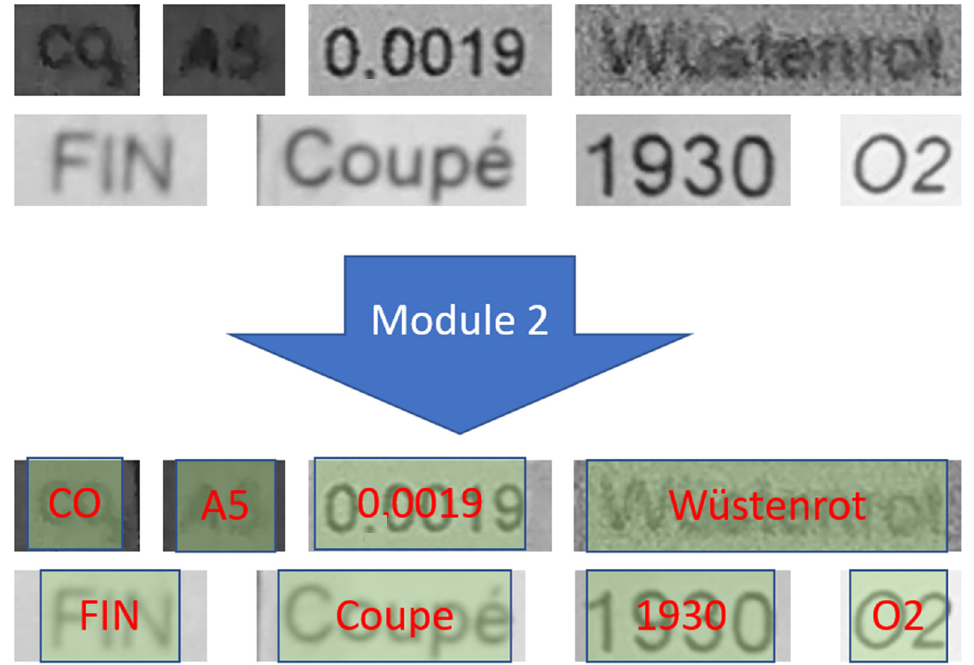
Figure 17. Sample of text recognition using Tesseract (open-source OCR system) and our novel OCR model. As we can see, most of the text samples are recognized in these images, but Tesseract cannot read them. Table 3. These results compare the performance of our model (for text recognition) with that of relevant selected state-of-the-art models under the same conditions.